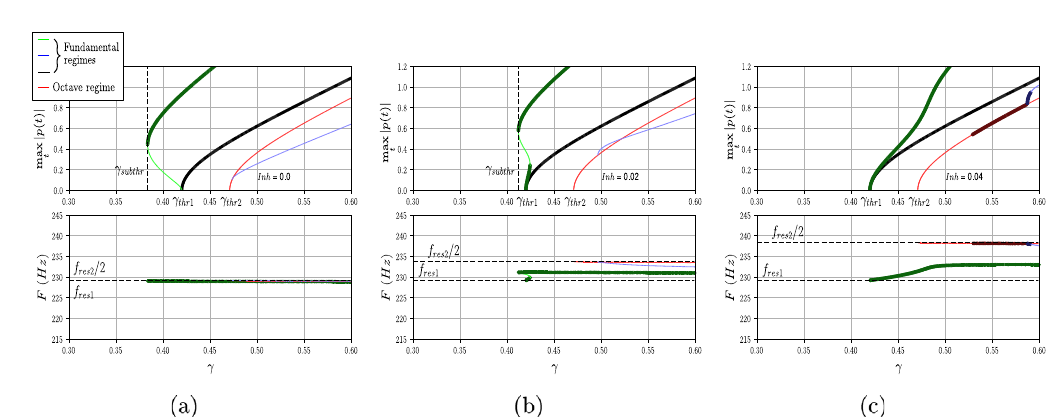
x p f n = 2 resn Z n Q n